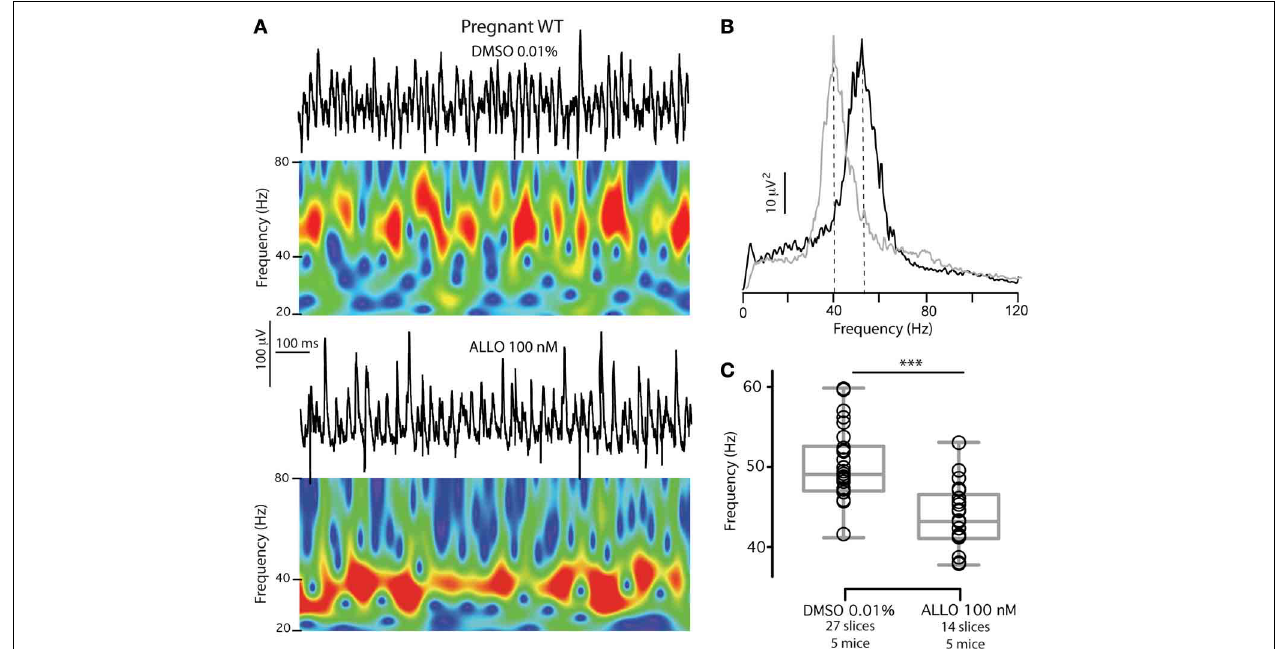
FIGURE 8 | Exposure to ALLO levels found in pregnancy (100nM) reverts CA3 γ oscillations frequency in pregnant mice to control values. (A) Representative 1s epoch of local field potential oscillations and corresponding Morlet wavelet transforms of 1s epochs of local field potentials recorded in the presence of 50nM kainate depict γ oscillatory behavior over time. Slices from the same pregnant WT animal were incubated and recorded in either vehicle (DMSO 0.01%) or ALLO 100nM.